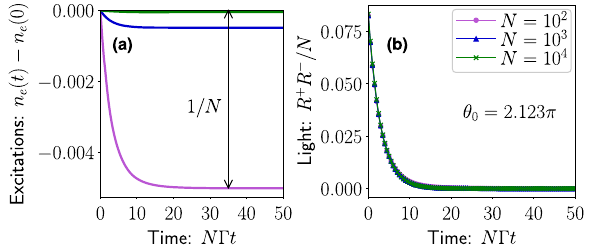
FIG. 9. Decay of MF dark to quantum dark. Cumulant results 1 = 2 ; 3 = 2 Þ starting ; F are shown for the six-level system ð F g e Þ ¼ ð ˆ R (cid:2) in j g − 1 and being excited by an drive with pulse area = 2 i V 2 . 123 π . This θ θ Þ , i.e., a θ 0 ¼ 0 corresponds to a minimum of V ð MF dark state; cf. Fig. 8(a). (a) Decay of the excited-state 0 Þ plotted with respect to the initial t Þ − n population n e ð e ð 0 Þ for different atom numbers N [see legend in population n e ð (b)]. The change in population is of order 1 =N . (b) Intensity of ˆ R þ ˆ R − light emission normalized by N as h i =N . The results for different N collapse on top of each other. We note that TWA simulations show the same N